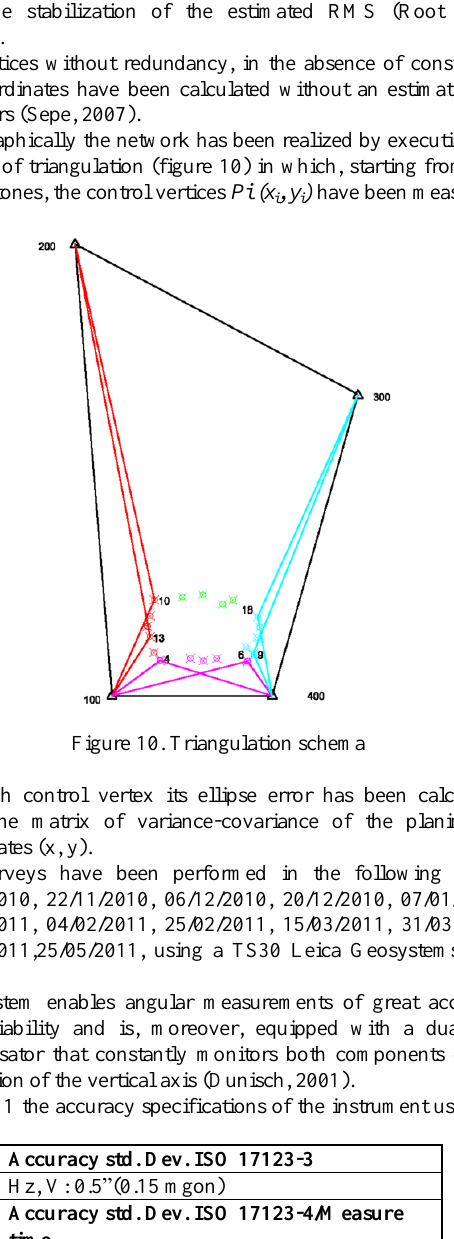
Table 4. Comparison of the vertices coordinates with time t